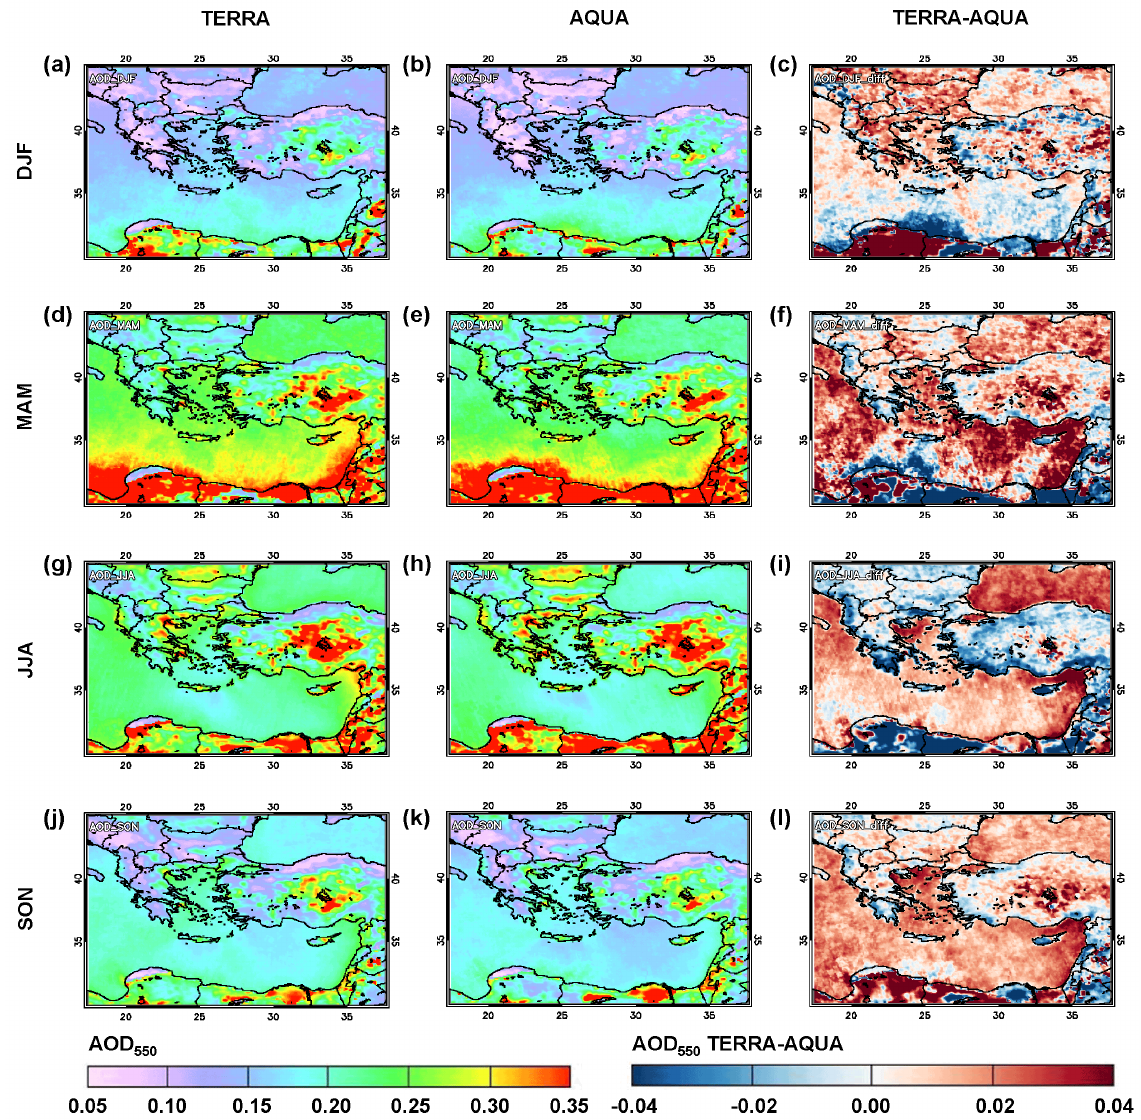
Figure 6. Seasonal AOD 550 patterns over the Eastern Mediterranean as seen by MODIS Terra (left column) during the period March 2000– December 2012 (March 2000–December 2007 for regions of northern Africa covered by DB data only) and MODIS Aqua (middle column) during the period July 2002–December 2012. The differences between MODIS Terra and Aqua AOD 550 on a seasonal basis appear in the right